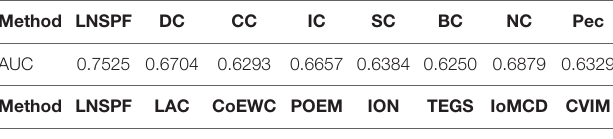
TABLE 5 | Based on DIP database, LNSPF and AUC of 14 competitive